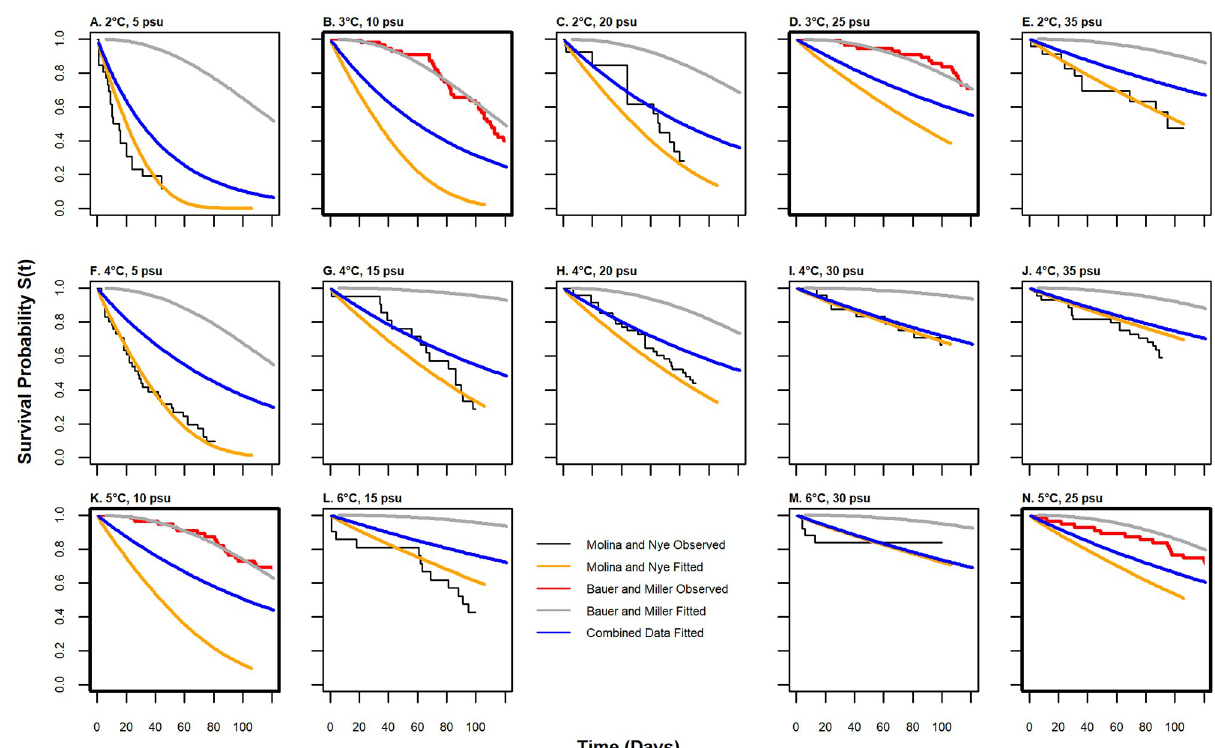
Fig 6. Observed and predicted survivorship for the 10 treatments from this study and the 4 treatments from Bauer and Miller [52]. Kaplan Meier estimators of the observed data for each temperature and salinity treatment combination are shown in the step-like black line for both Chesapeake Bay and Great South Bay crabs from the present study, and in red for the observed data from Bauer and Miller [52]. The solid lines show predicted model fits for three different models, using average values of temperature, salinity, and carapace width (mm) from each treatment as the predictive variables in the model. The text above each panel indicates the experimental temperature and salinity level for that treatment. Panels B, D, K, and N, which are outlined with a thick box, show data from [52] while the rest are data from our experiments (A) Temperature = 2 ˚C and salinity = 5 psu, (B) Temperature = 3 ˚C and salinity = 10 psu, (C) Temperature = 2 ˚C and salinity = 20 psu, (D) Temperature = 3 ˚C and salinity = 25 psu, (E) Temperature = 2 ˚C and salinity = 35 psu, (F) Temperature = 4 ˚C and salinity = 5 psu, (G) Temperature = 4 ˚C and salinity = 15 psu, (H) Temperature = 4 ˚C and salinity = 20 psu, (I) Temperature = 4 ˚C and salinity = 30 psu, (J) Temperature = 4 ˚C and salinity = 35 psu, (K) Temperature = 5 ˚C and salinity = 10 psu, (L) Temperature = 6 ˚C and salinity = 15 psu, (M) Temperature = 6 ˚C and salinity = 30 psu, (N) Temperature = 5 ˚C and salinity = 25 psu.